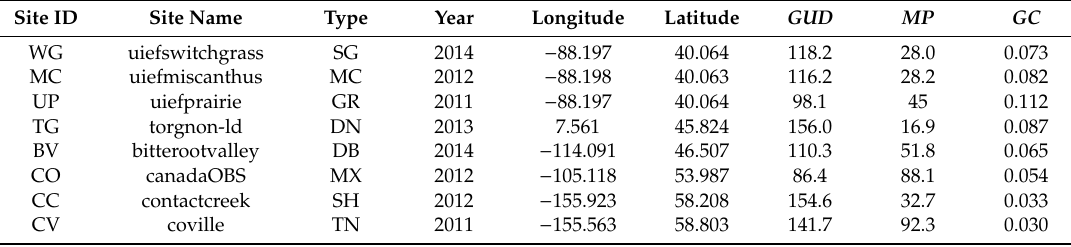
Table 1. Details of the eight sites where data were gathered for GCC curves used for the simulation. The abbreviations of vegetation types are switchgrass (SG), miscanthus (MC), grassland (GR), deciduous needleleaf (DN), deciduous broadleaf (DB), mixed vegetation (MX), shrubs (SH), and tundra